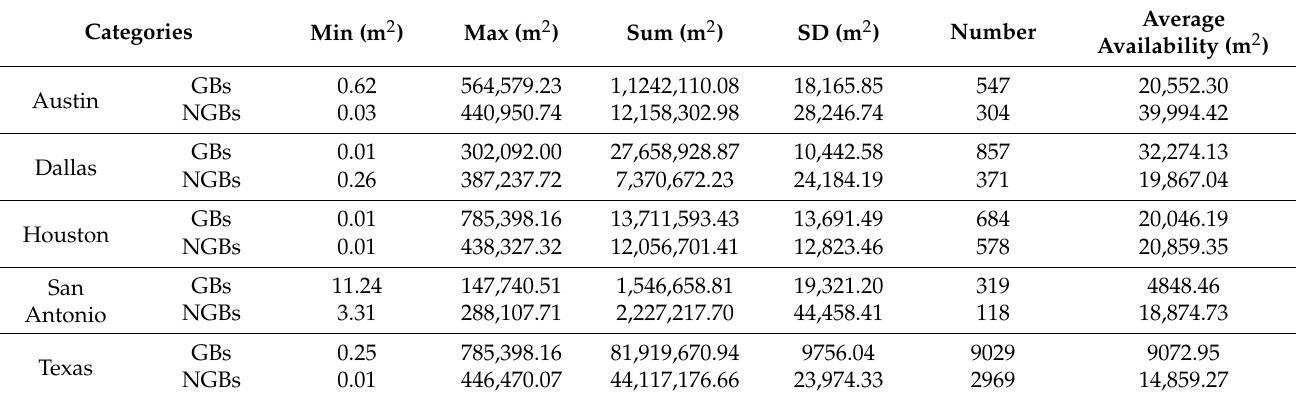
Table 2. Availability of green spaces for green and nongreen buildings.